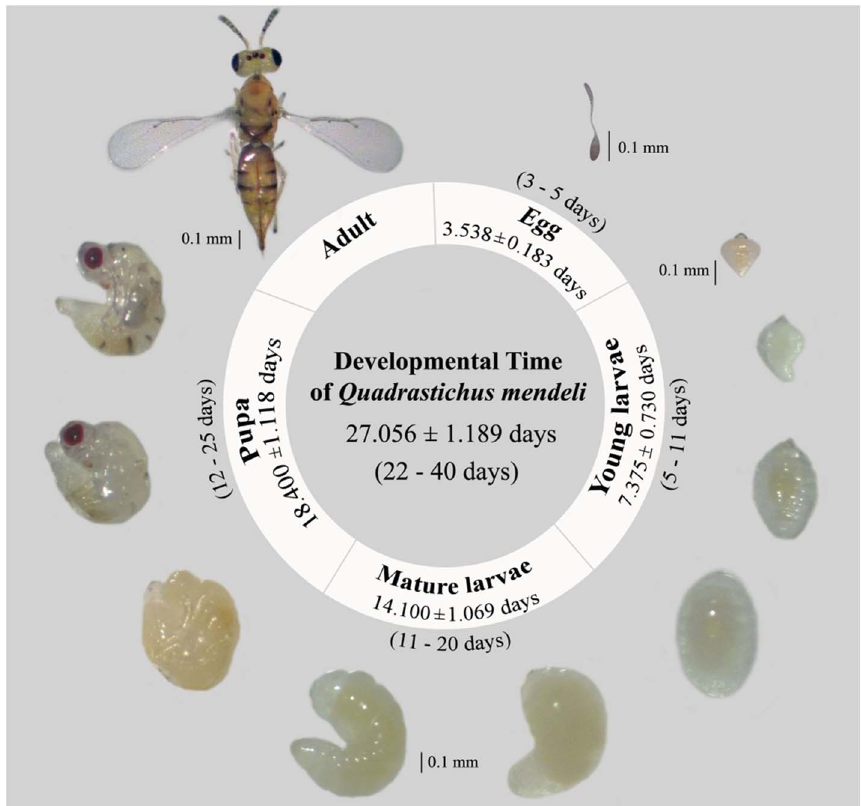
Figure 6. Development of Quadrastichus mendeli . Values are shown as mean ± SE ; range is shown in parentheses = (minimum –